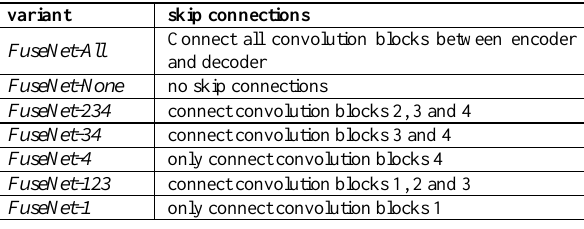
Table 1: Network variants with different